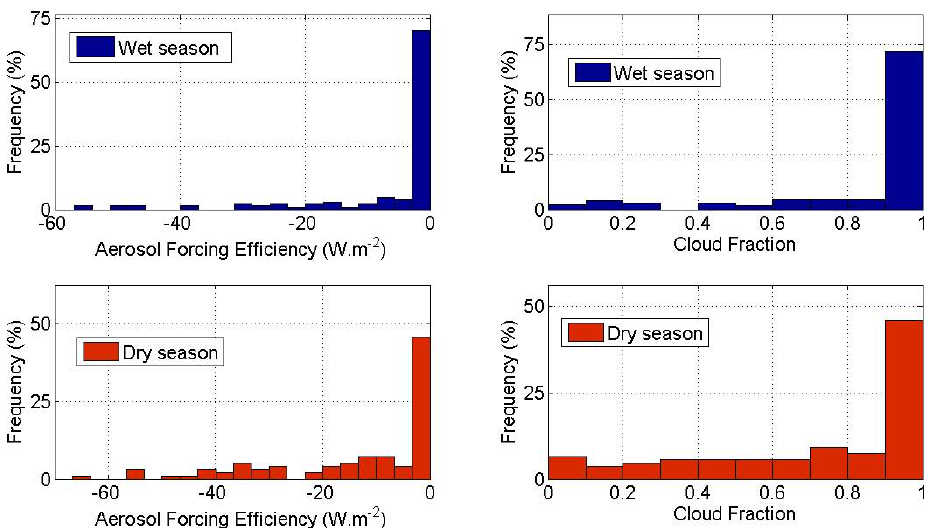
Fig. 12. Frequency histograms for the aerosol forcing efficiency and for the cloud fraction during wet and dry seasons, comprising the period between November 2009 and September